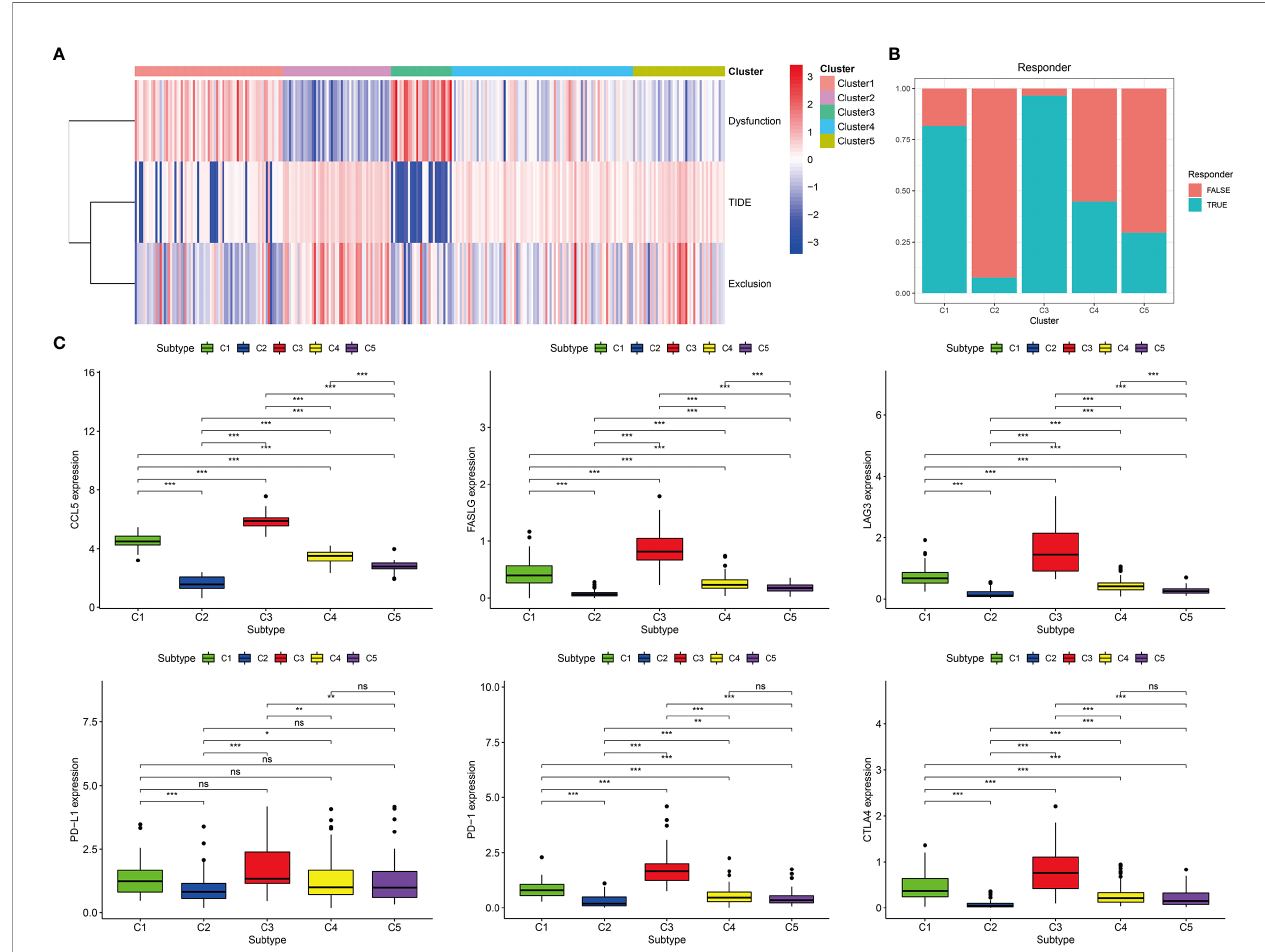
FIGURE 7 | Prediction of immunotherapy response of fi ve immune subtypes in the TCGA cohort. (A) Heat map of dysfunction scores, exclusion scores, and TIDE scores of fi ve immune subtypes. (B) Histogram of responder of fi ve immune subtypes (true responder: C1 81.7%, C2 7.7%, C3 96.6%, C4 44.8%, C5 29.5%). (C) Gene expression levels of PD-1, PD-L1, CTLA4, LAG3, FASLG, and CCL5 among fi ve immune subtypes, ***p < 0.001, **p < 0.01, *p < 0.05, ns p >